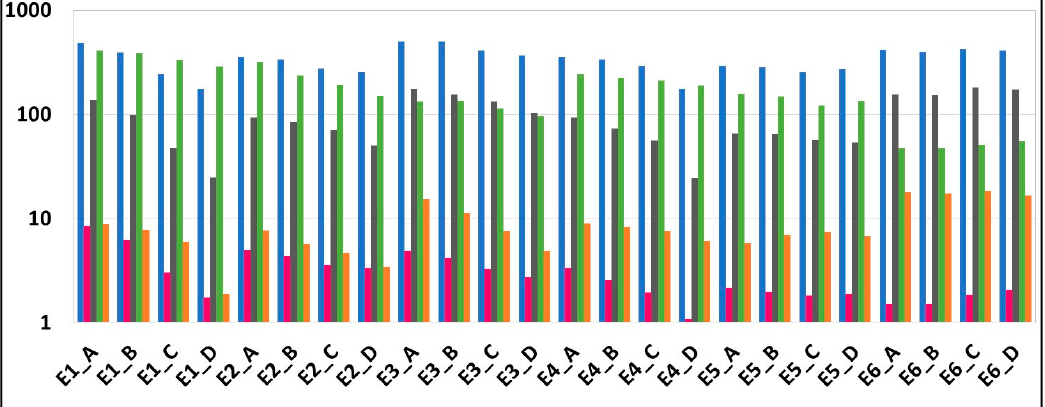
Figure 12. Summary of averaged measured data: HTC , water impingement density, impact pressure, Sauter mean diameter of the droplet d 32 , droplet mean velocity v p for all experiments.